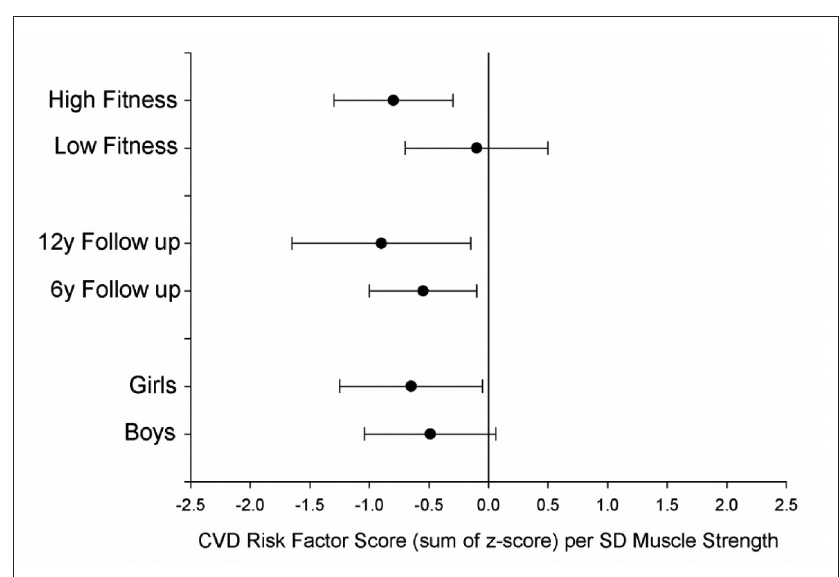
Figure 3. Isometric muscle strength in youth and composite cardiovascu- lar risk factor score in young adult- hood stratified by cardiorespiratory fitness (below and above the median, sex specific), follow-up time (6- or 12 years), and sex. Adapted from Grøntved et al.